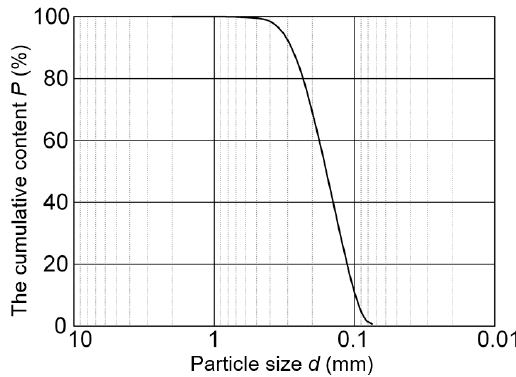
Figure 2. Grain size distribution of